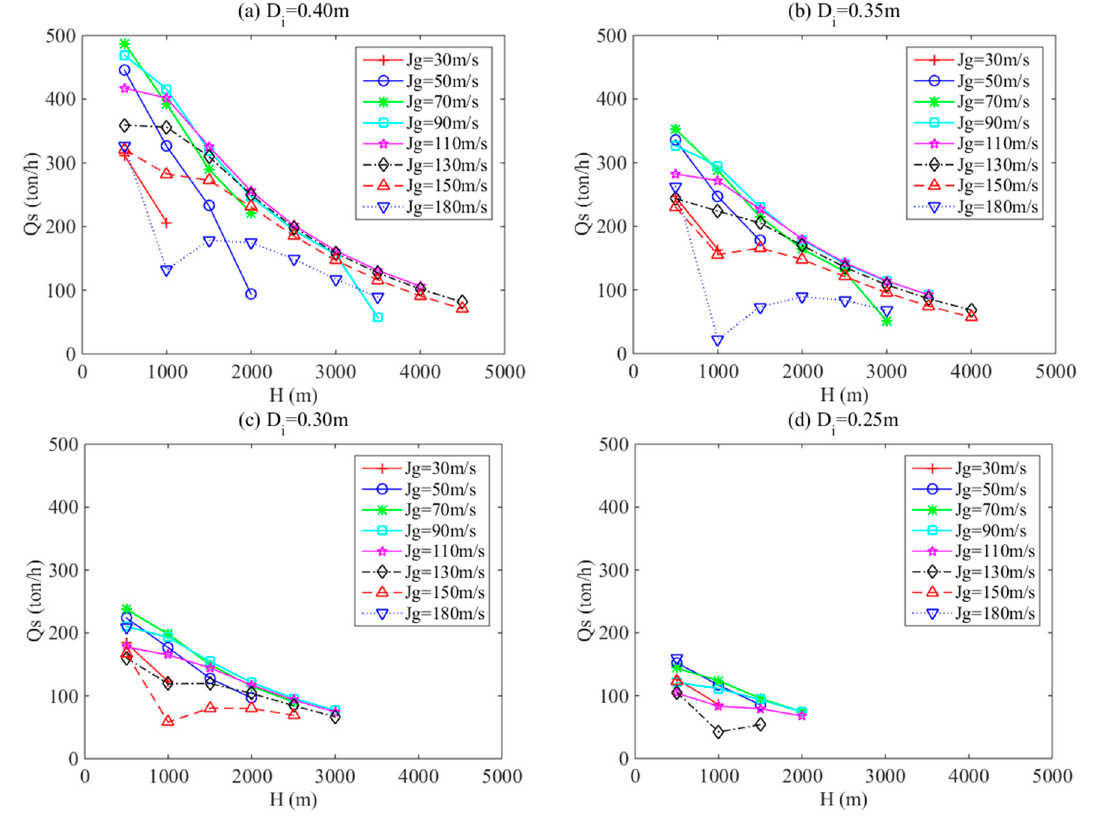
D at different mining i